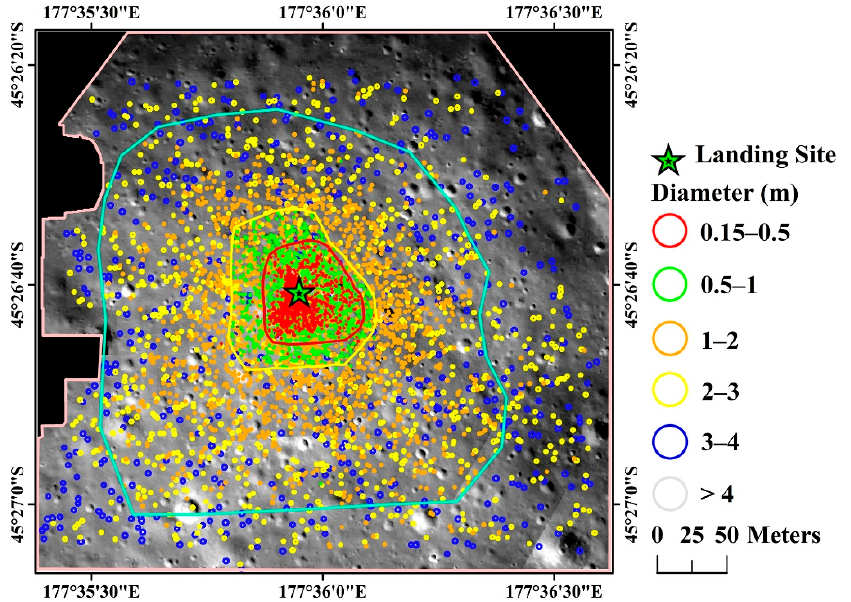
Figure 6. The mosaicked LCAM image with boundaries of areas defined by different sizes of visible craters. The red, the yellow, the aquamarine, and the pink outlined areas correspond to impact craters with a minimum diameter of 0.15, 0.5, 1, and 2 m that can be identified, respectively, as constrained by the limitations of the resolution of descent images.